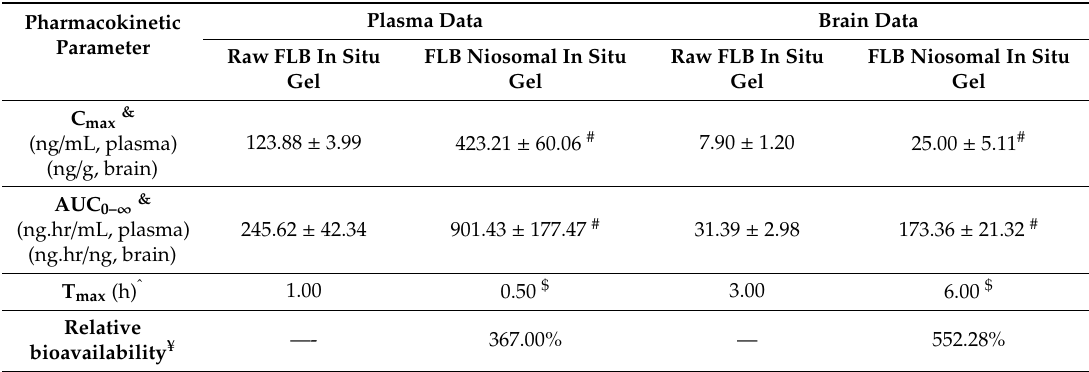
Table 6. In vivo pharmacokinetic parameters following intra-nasal administration of optimized FLB niosomal in situ gel compared to raw FLB in situ gel.